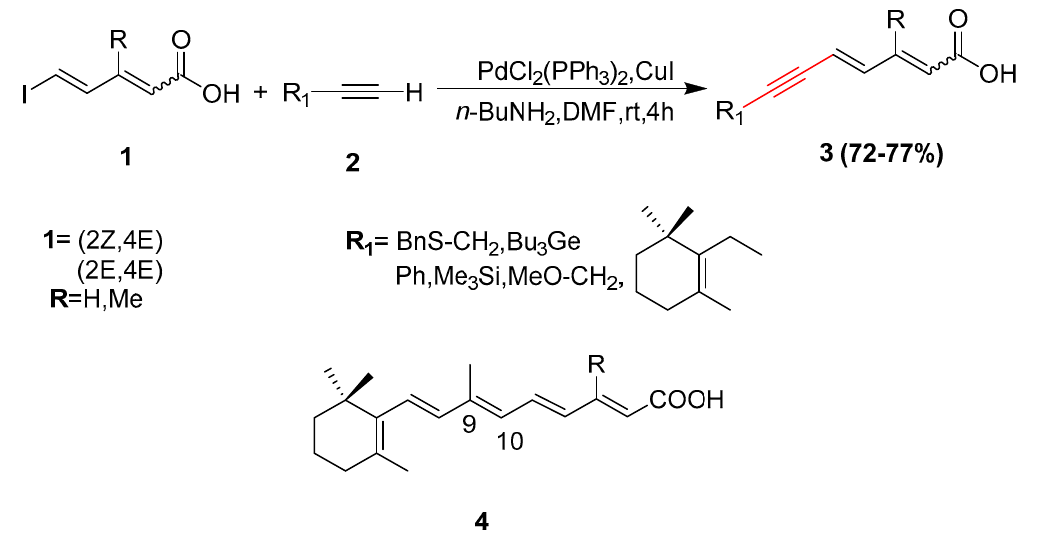
Scheme 1. Stereoselective Synthesis of 9,10-didehydro retinoic